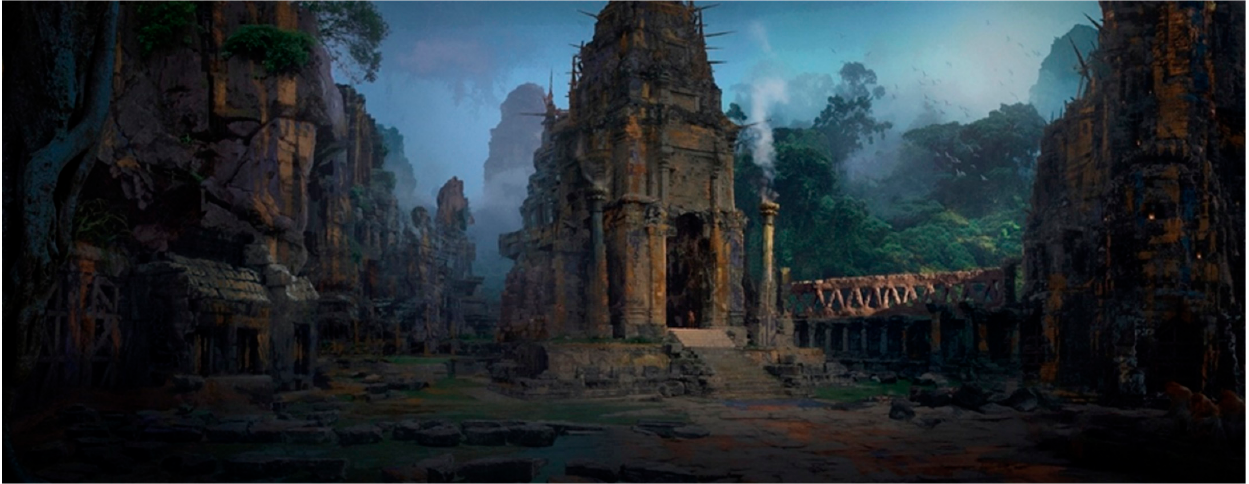
Figure 19. The constructions of the town of Skull Island look like Buddhist temples (2017). https://formlanguage.artstation.com/projects/eXweZ (accessed on 1 January 2021).